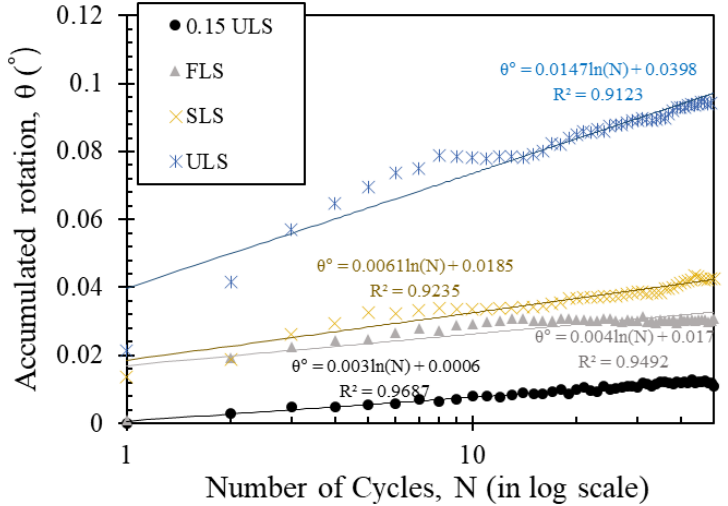
Figure 13. Prediction curves of permanent displacement of on-site OWT.